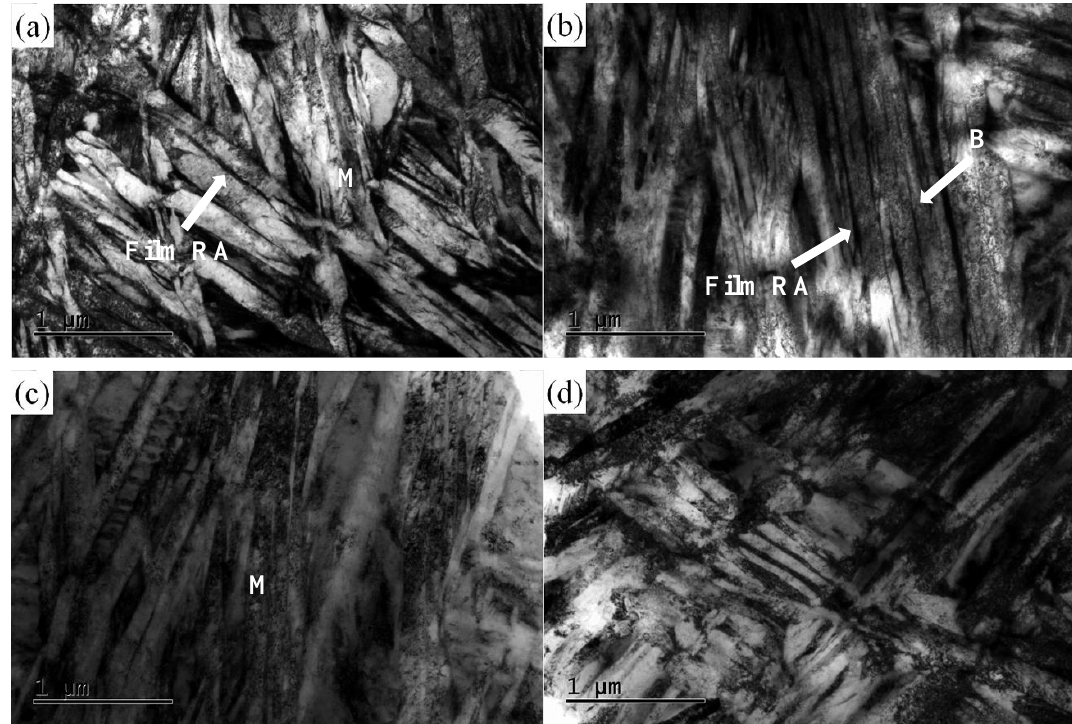
Figure 4. TEM images of experimental steel treated by isothermal transformation at 220 °C for different times and tempering: ( a ) 3 h; ( b ) 3 h and tempered at 250 °C for 2 h; ( c ) 7 h; ( d ) 15 h. (M: martensite, B: bainite, Film RA: film retained austenite).